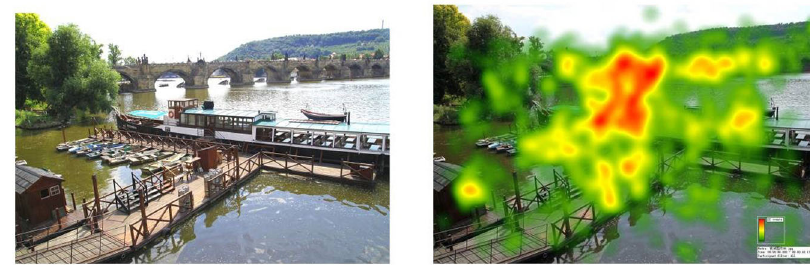
Fig. 18 The comparison of eye motion and heatmap for the river